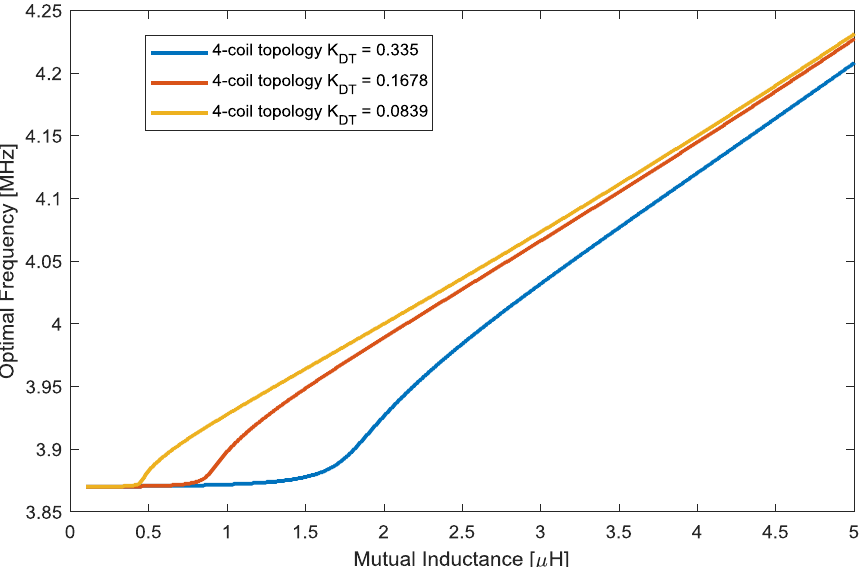
Figure 8. Tuned Frequency adjusted by the frequency control system to maximize efficiency in a 4- coil topology.